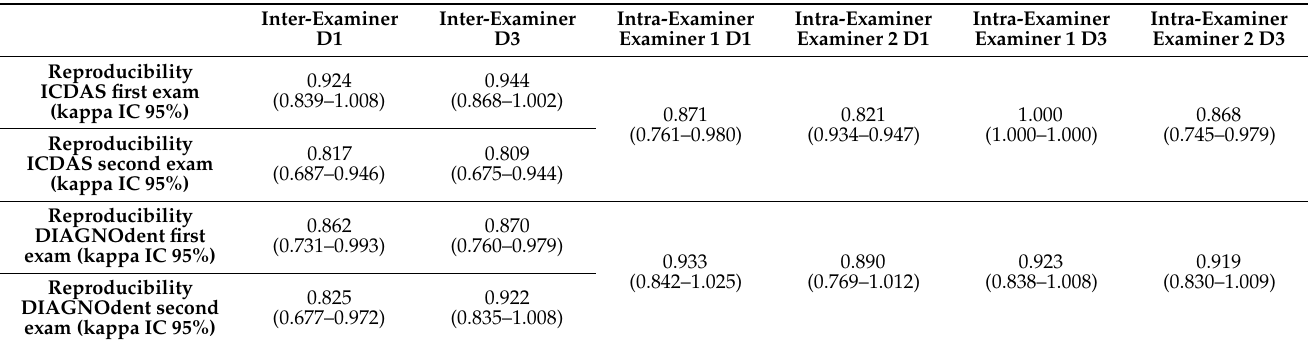
Table 1. Intra- and inter-examiner Reproducibility of ICDAS and DIAGNOdent for lesions limited to enamel (D1) and dentin